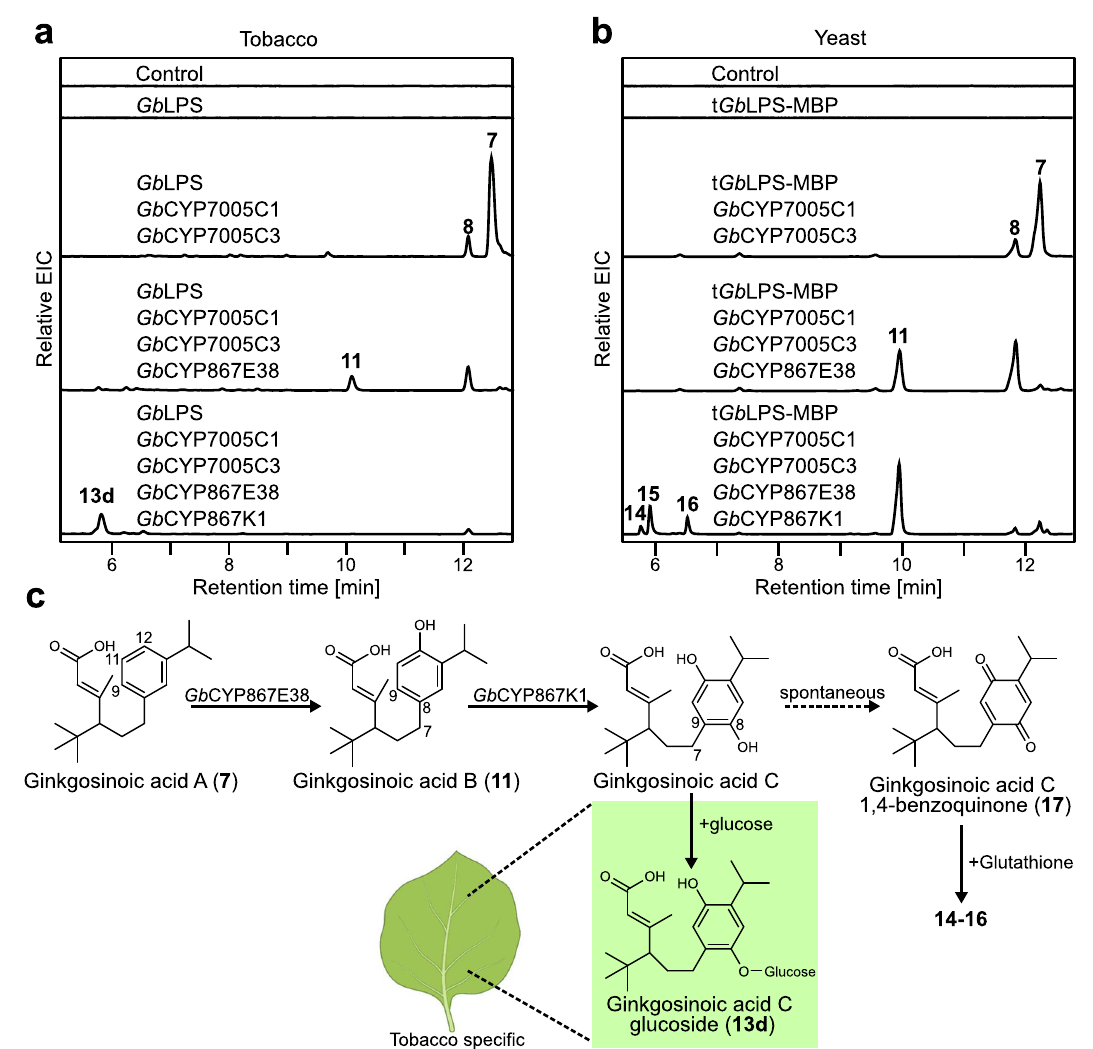
Fig. 3 | Coordinated action of BGC-localized Gb CYPs ( Gb CYP7005C1, Gb CYP7005C3, Gb CYP867E38, and Gb CYP867K1) advances ginkgolide bio- synthesis.a LC – HRMS analysisof tobaccoleafextractsexpressing Gb LPS and CYP combinations as shown above each chromatogram. In all tobacco samples, Cf DXS ( C. forskohlii 1-deoxy-D-xylulose 5-phosphate synthase), Cf GGPPS ( C. forskohlii geranylgeranyl pyrophosphate synthase), and the P19 silencing suppressor are co- expressed. The chromatograms shown are extracted ion chromatograms (EICs, positive mode) for the m / z values of 187.1482; 203.1425; 317.2118; and 335.2218, eachwithawindowof±0.05. b LC –